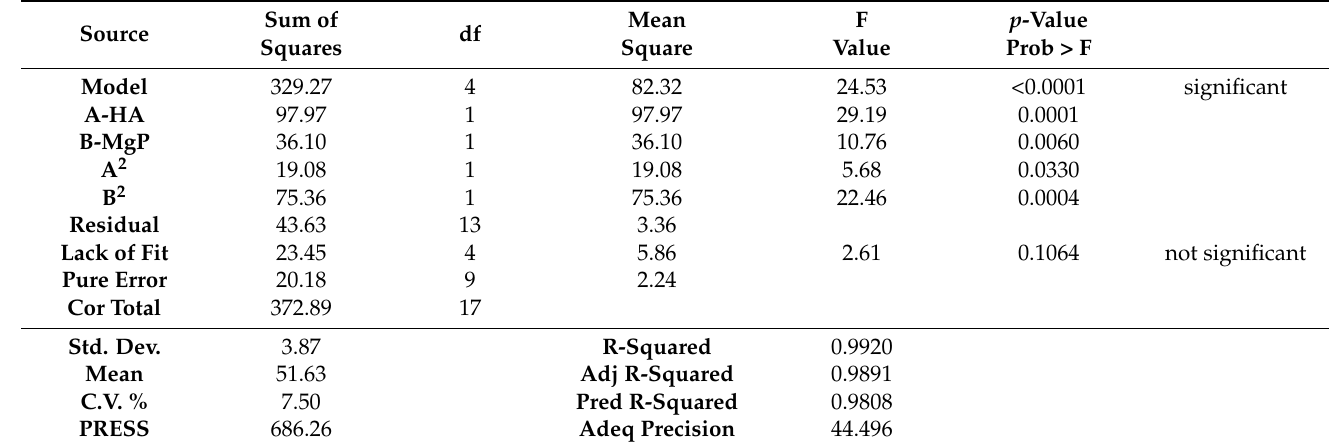
Table 5. ANOVA table for the reduced quadratic model (cell viability).